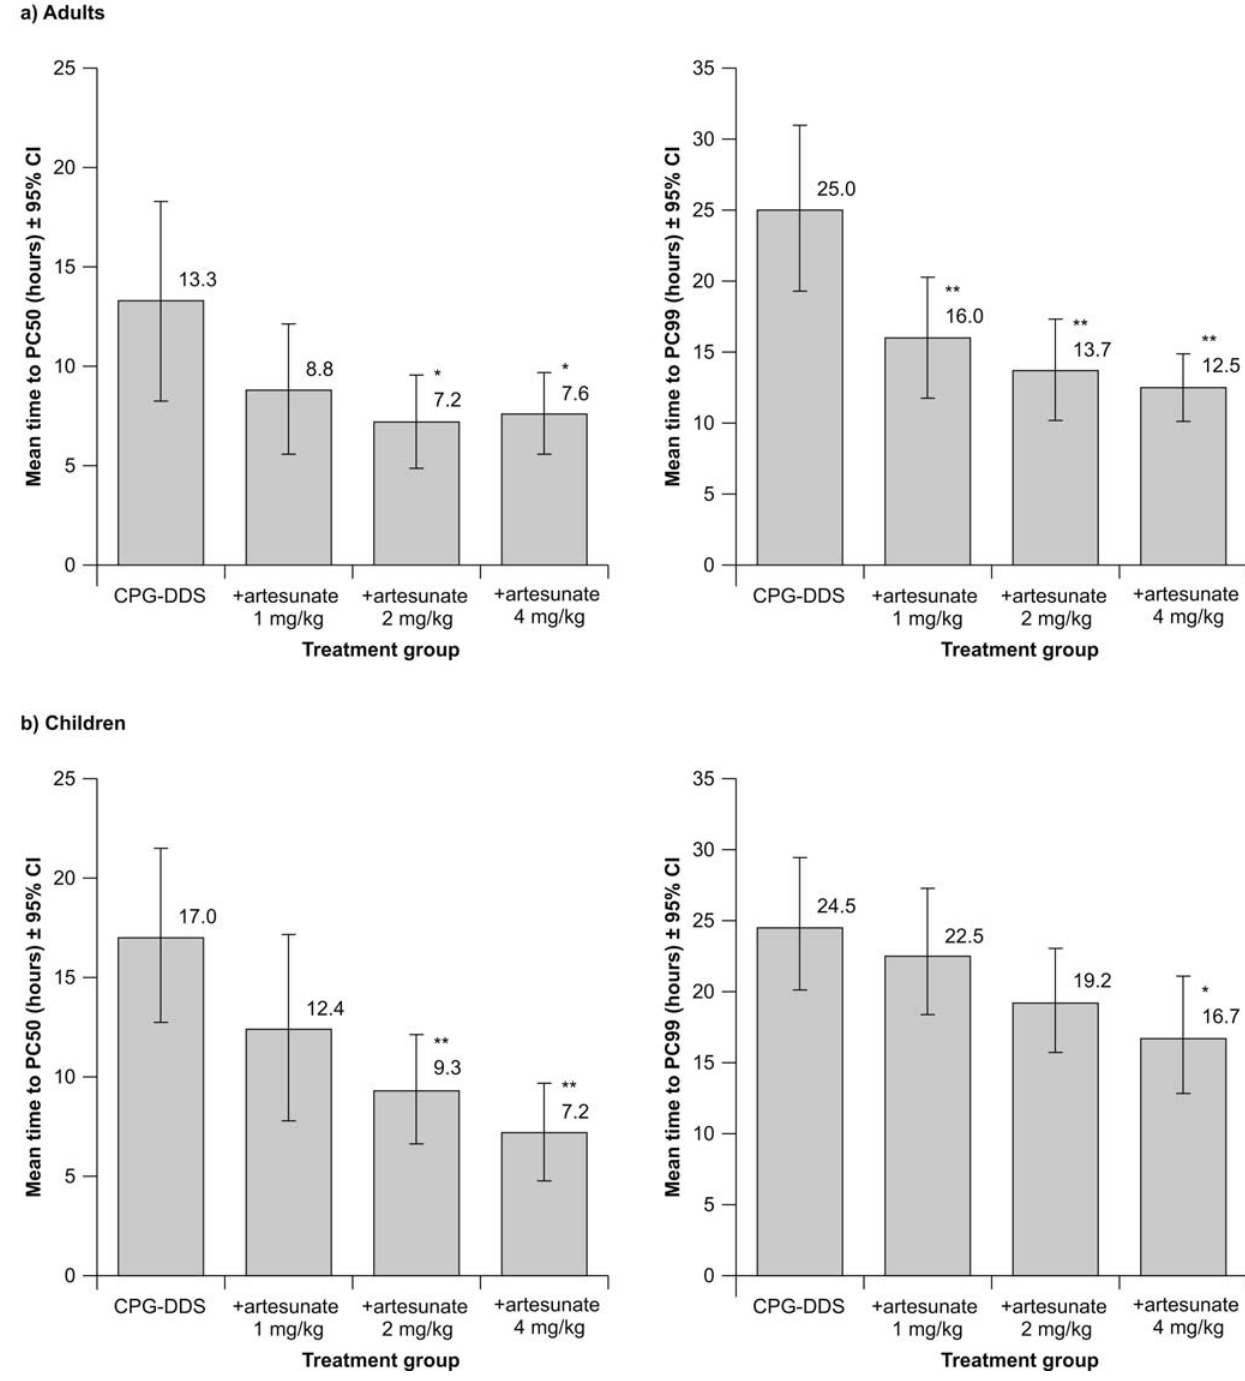
Figure 3. Results for Day 3 per-protocol population for mean time to PC50 and mean time to PC99 for (a) adults and (b) children. *P # 0.05 versus CPG 2 DDS alone; ** P # 0.01 versus CPG–DDS alone. Five adults (two in the CPG 2 DDS group, two in the + artesunate 1 mg/kg group and one in the + artesunate 2 mg/kg group) and 14 children (three from the CPG 2 DDS group, and five, three and three from the + artesunate 1, 2 and 4 mg/kg groups, respectively) were excluded from the mean time to PC50 analysis due to poor model fit. Seven adults (five in the CPG 2 DDS group, and one each in the + artesunate 1 mg/kg and 2 mg/kg groups) and five children (two from the CPG 2 DDS group, two from the + artesunate 1 mg/kg and one from the + artesunate 2 mg/kg group) were excluded from the mean time to PC99 analysis due to poor model fit.